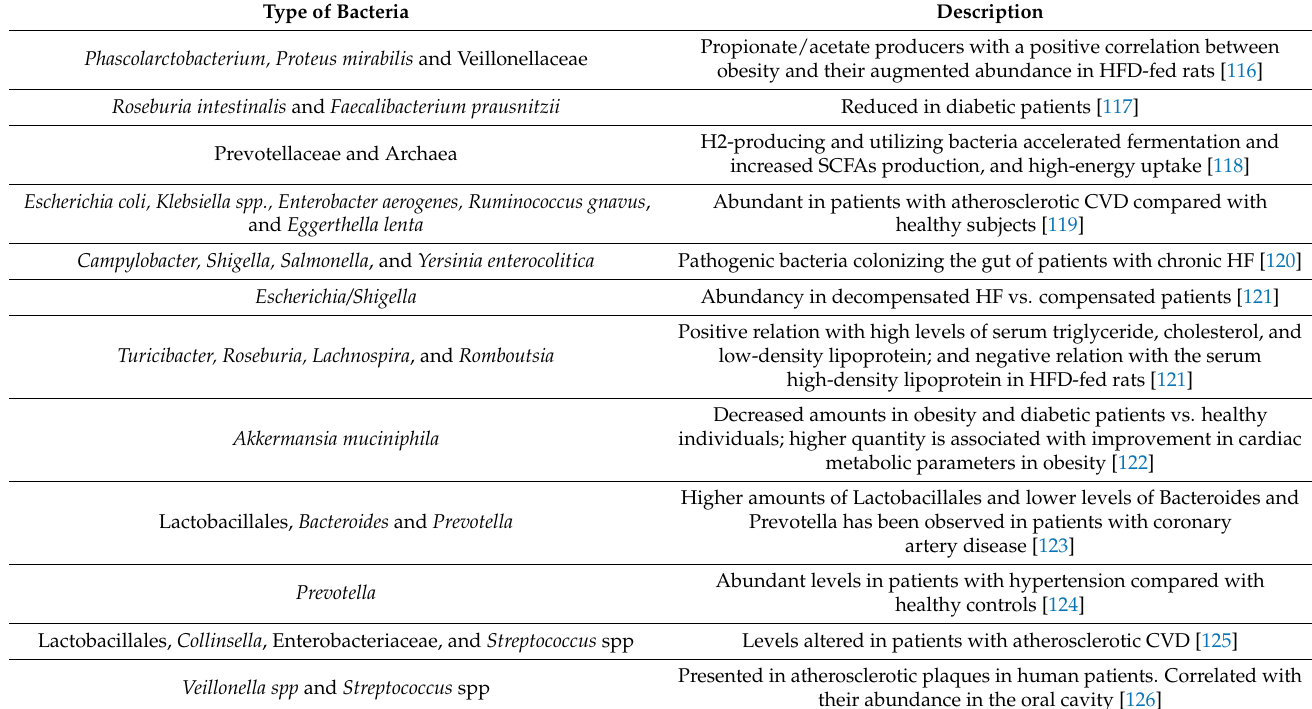
Table 1. Bacteria involved in CVD development.